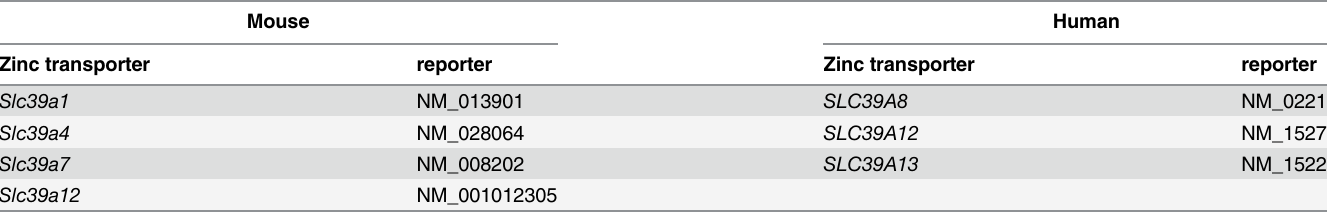
Table 6. Overview of zinc transporters that are highly expressed in human and mouse RPE. Mouse Human Zinc transporter reporter